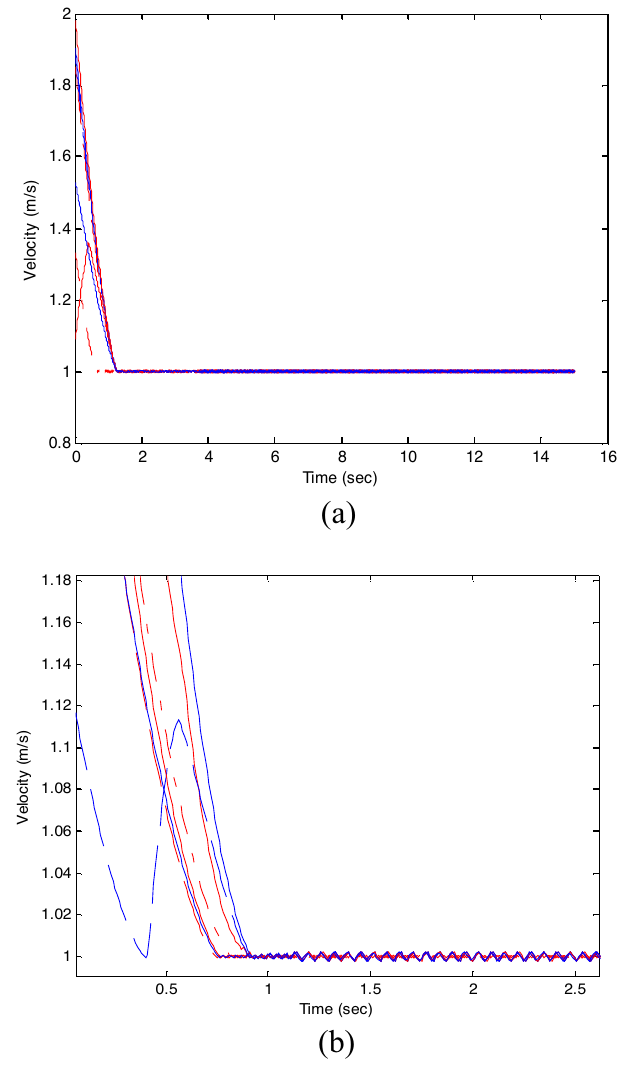
Figure 3. Consensus control on velocity of seven agents ( b ) local magnification of figure ( a